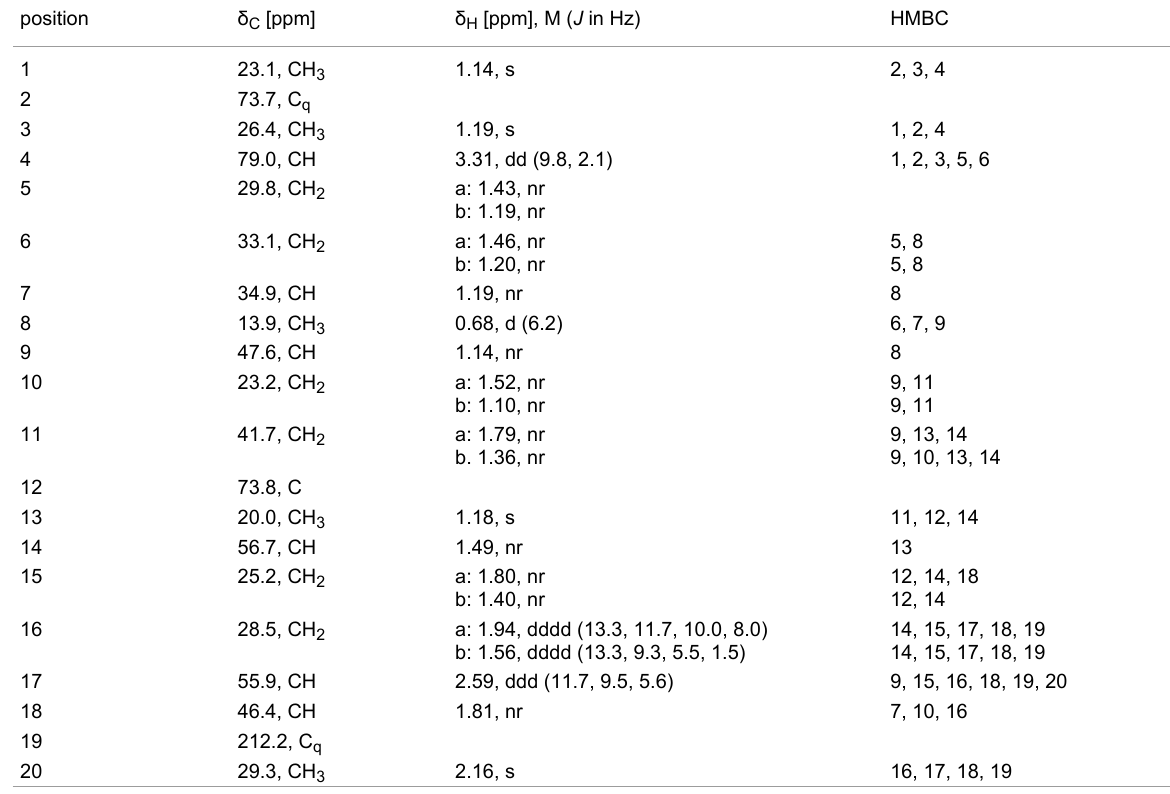
Table 1: NMR spectroscopic data of herpetopanone ( 1 ) in chloroform- d 1 . a